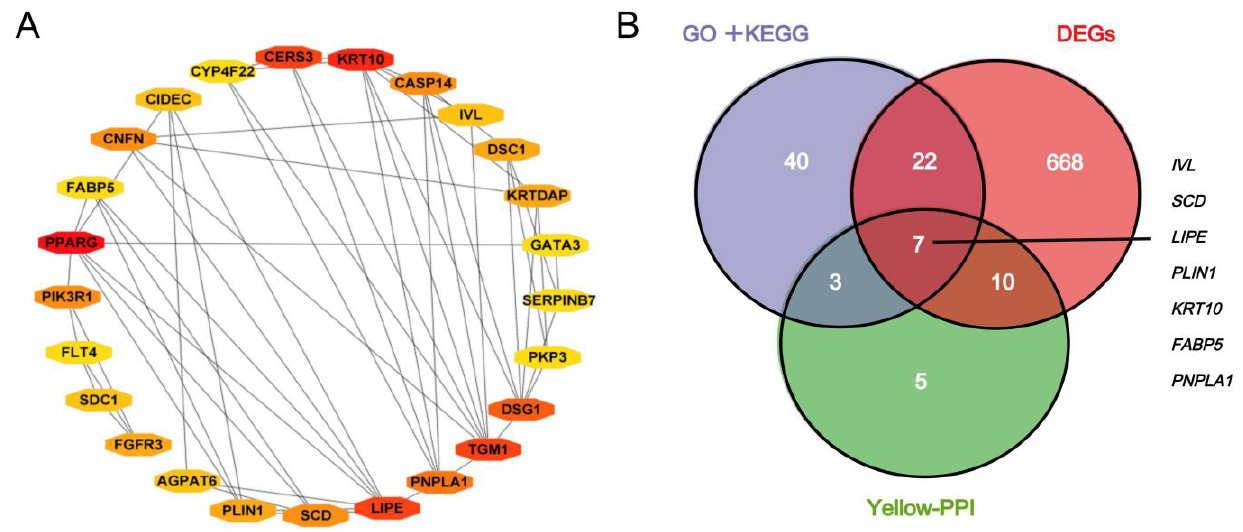
Figure 4. Hub genes in the yellow module. ( A ) Network visualization of the co-expression of 25 hub genes in yellow module. ( B ) The intersection in the Veen map is the most important candidate genes by various analysis methods. Table 1. Positive selection at amino acid sites of seven candidate genes in domestic